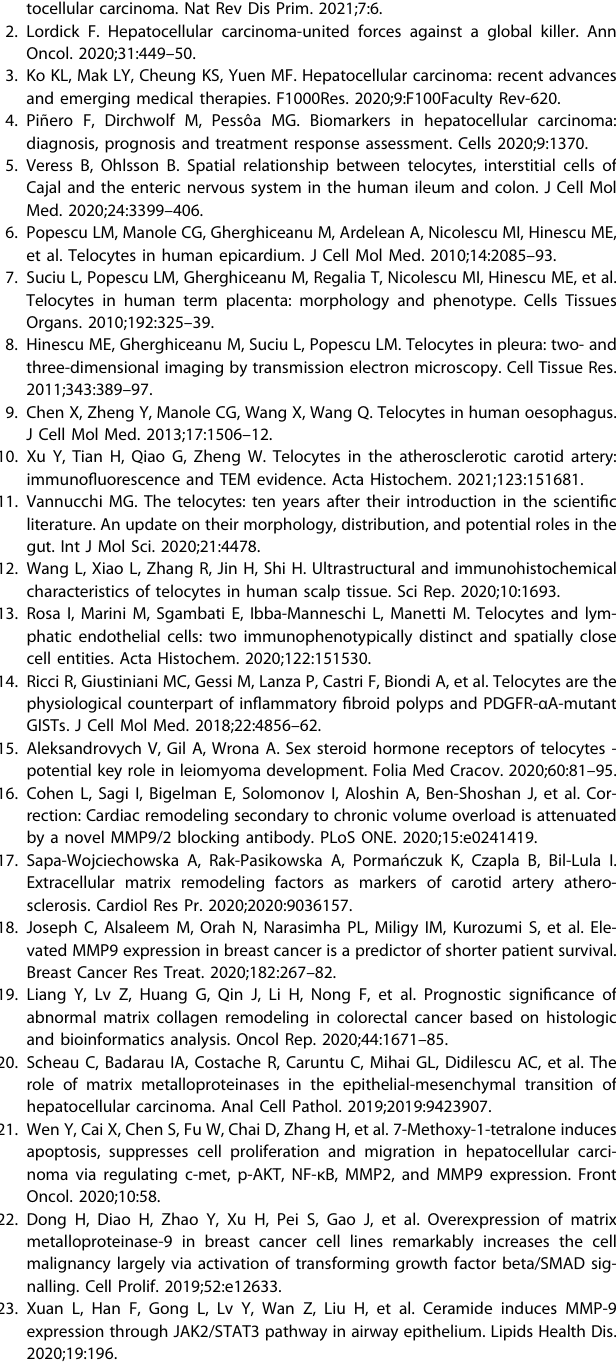
Fig. 5 MMP9 expression in telocytes as regulated by the Ras/ERK signaling pathway and miR-942-3p. HepG2 cells secreted PDGF- α , but not MMP9 ( A ). MMP9 expression measured using different TC and PDGF- α concentrations ( B ). Simulation of the mechanism underlying MMP9 secretion by TCs involving the Ras/ERK signaling pathway and relative miRNA ( C ). PDGF- α stimulates TCs to express MMP9 according through the activation of the Ras/ERK signaling pathway that is inhibited by U0126 and AZ-628 ( D ). Differences between the expression levels of miR-942-3p in TCs of HCC para-cancer and normal liver tissues ( E ). Predicted binding site of miR-942-3p on the 5 ′ UTR sequence of MMP9 and mutated sites of MMP9 ( F ). Relative binding observed between miR-942-3p, 5 ′ UTR of MMP9 mRNA, and the mutated MMP9 mRNA as determined by the luciferase reporter gene assay ( G ). Measurement of MMP9 mRNA and protein expression in TCs following overexpression or inhibition of miR-942-3p ( H , J ). Differential expression of MMP9 with the administration of miR-942-3p mimics or inhibitors as determined by western blot ( I